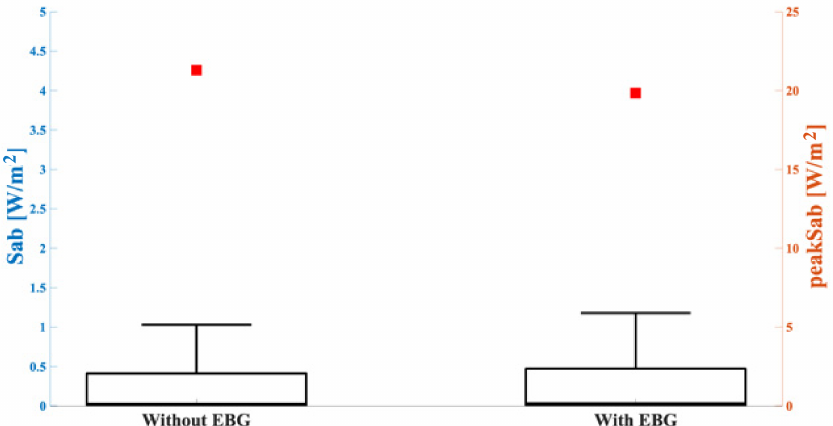
Figure 9. S ab (left y -axis, boxplot) and peak S ab (right y -axis, square symbols) in the tissues included in the cubical box relative to the configurations without (on the left) and with (on the right) the EBG mounted on the antenna. The bottom and top edges of the boxes are the 25th and 75th percentiles. The lower whisker extends to the minimum values, while the upper whisker extends to 1.5 times the height of the